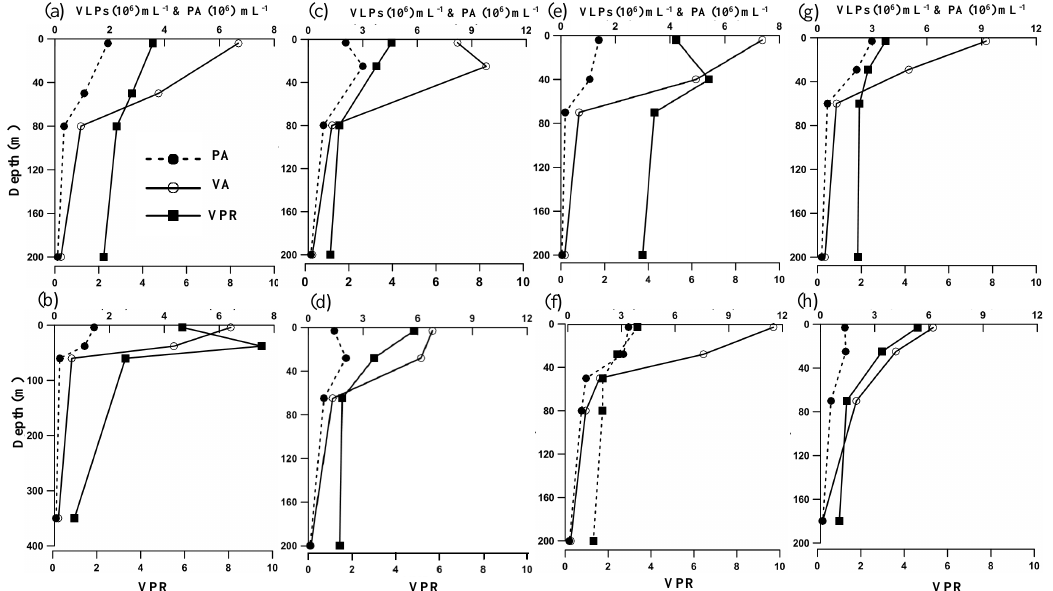
Figure 3. Vertical distribution of viral abundance (VA), prokaryotic abundance (PA) and virus to prokaryote ratio (VPR) at stations ( a ) L1; ( b ) L2; ( c ) L4 in 2015; ( d ) L3; ( e ) L4 in 2016; ( f ) L5; ( g ) L6; and ( h )